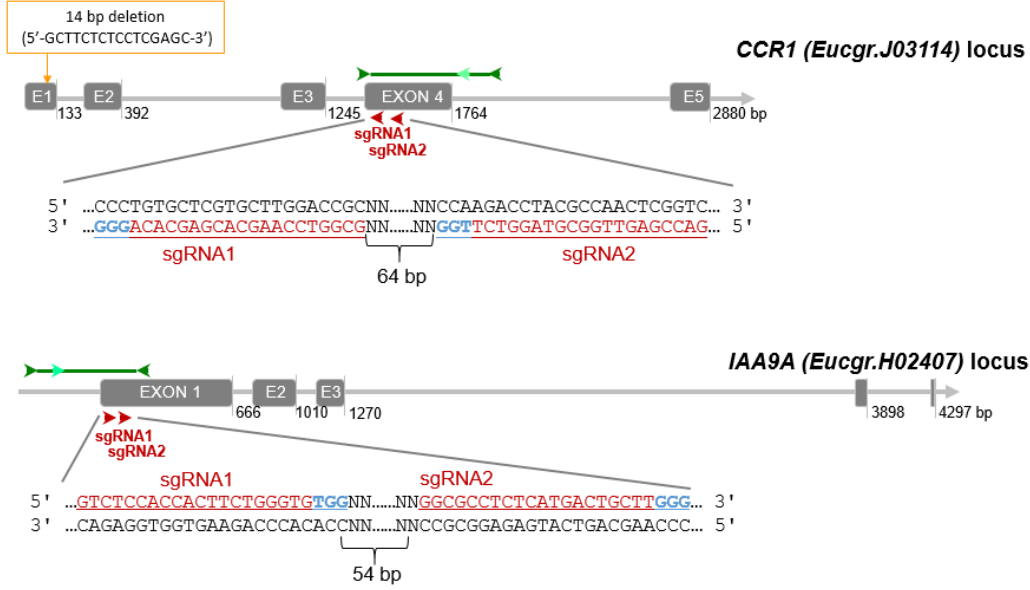
Figure 5. CRISPR / Cas9 sgRNA design and mutation detection in CCR1 and IAA9A . Schematic representation of the target sites and the PCR assay for Sanger sequencing. Exons and introns are represented by gray boxes and gray lines, respectively. The target sites for each CRISPR / Cas9 nuclease are indicated by red arrows, sgRNA target sequence are indicated in underlined red characters, PAM sequences in blue. The dark green arrows indicate approximately the location of the primers for PCR amplification, the light green arrows indicate the nested primers designed for DSDecode mutation identification.